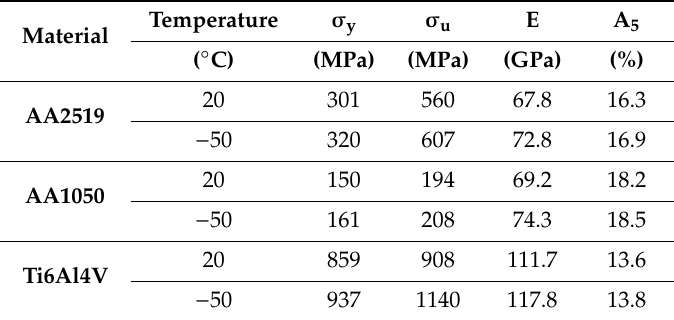
Table 1. Mean values of the mechanical properties of AA2519 aluminium alloy and Ti6Al4V titanium alloy at di ff erent